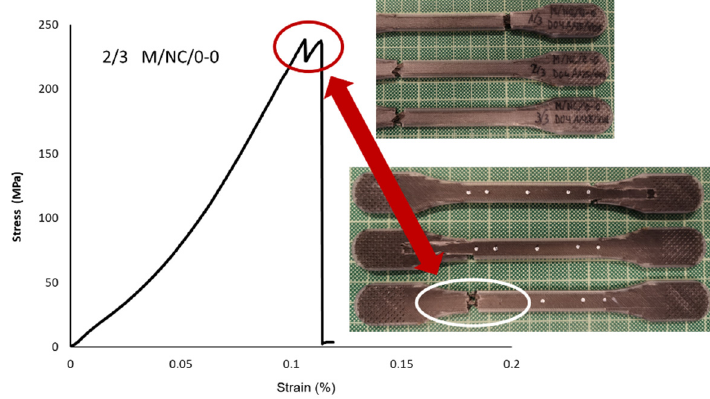
Figure 25. Detail of 2/3 M/NC/0-0 specimen breakage and stress-strain graph.